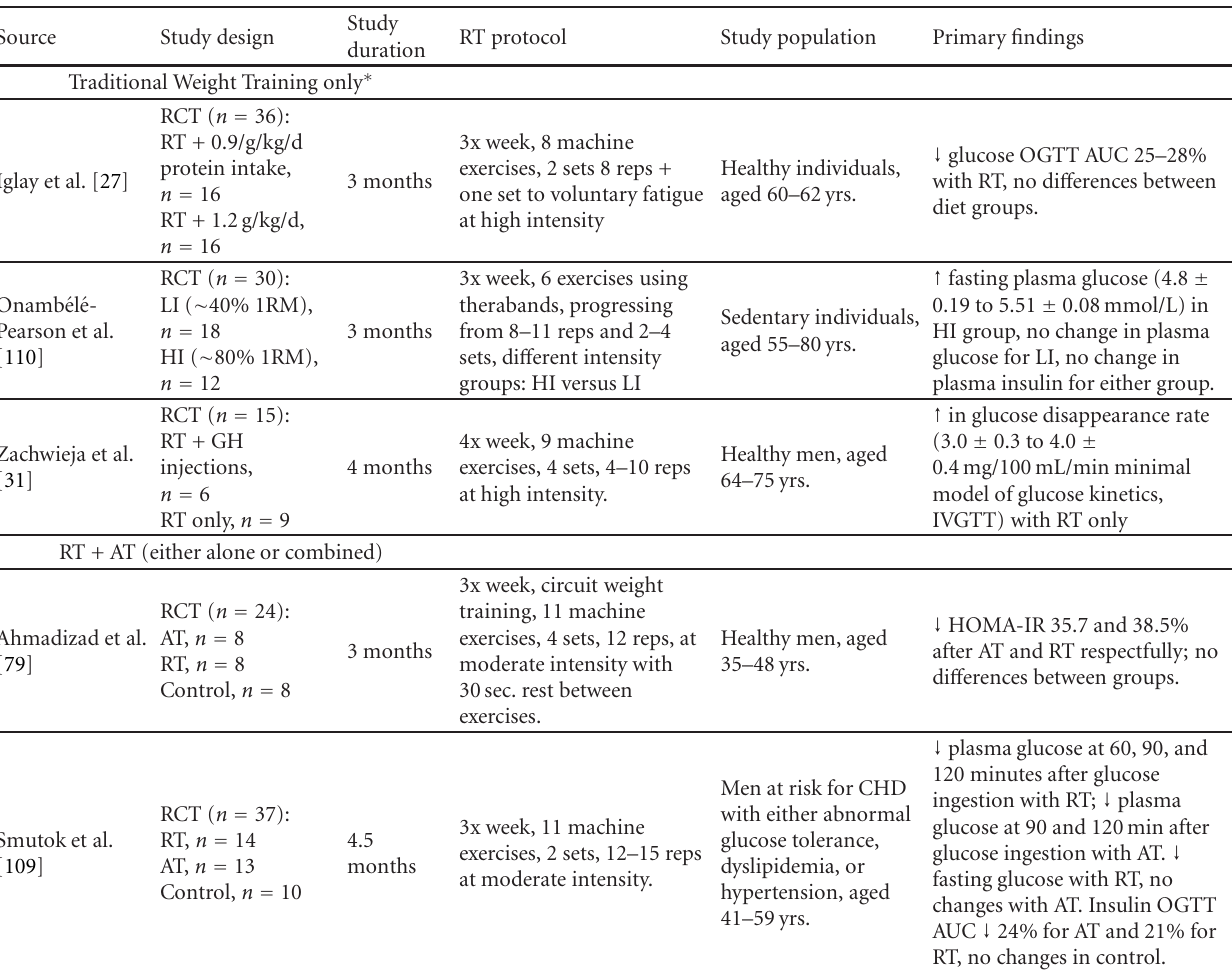
Table 1: Randomized controlled trials > 1 month in duration investigating the e ff ect of resistance training on diabetes-related outcomes among nondiabetic middle-aged and older adults †